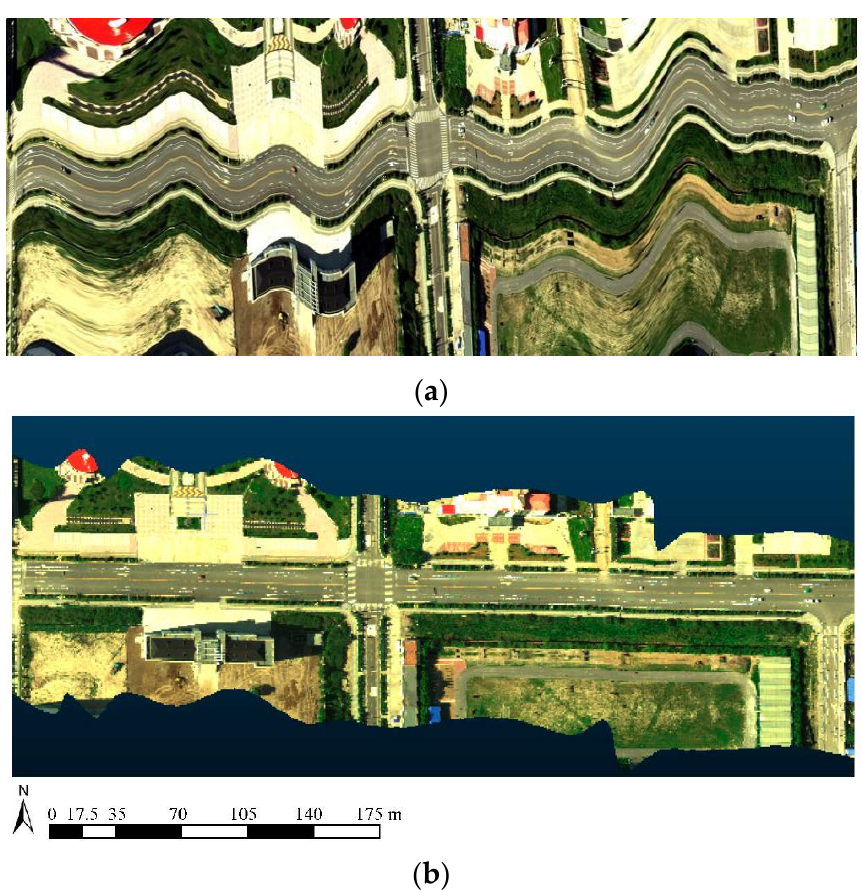
Figure 9. ( a ) The original hyperspectral pushbroom images from “LanTianHao” HAA; and ( b ) the